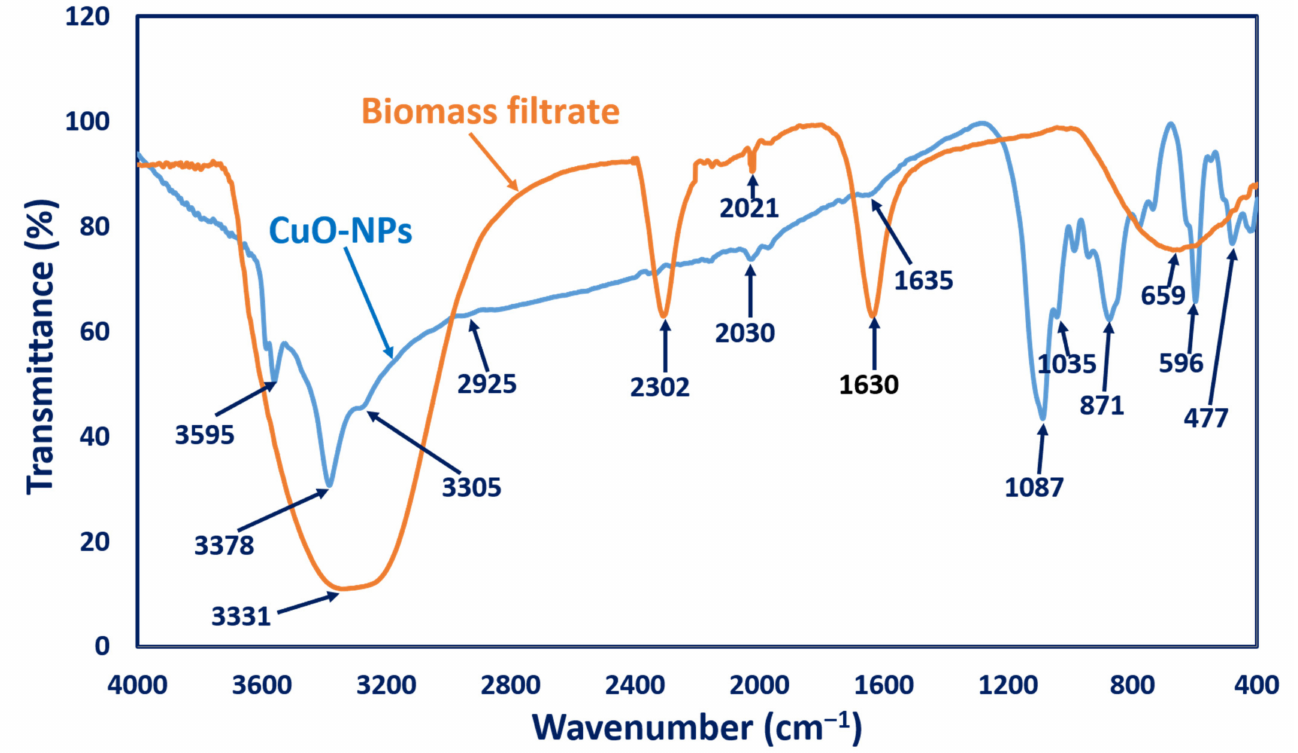
Figure 3. FT-IR of fungal biomass filtrate and CuO-NPs synthesized by Aspergillus niger